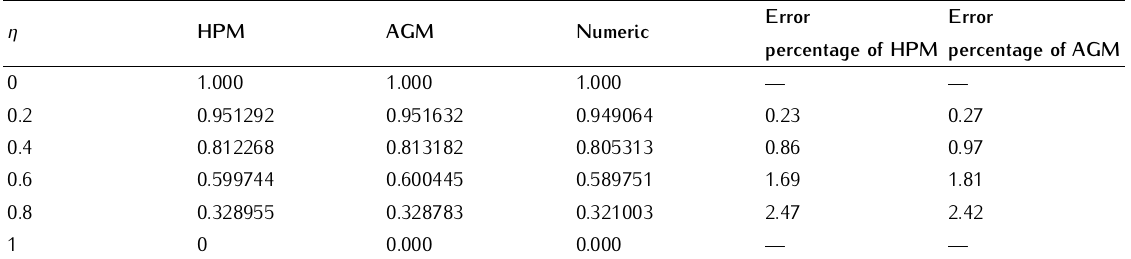
Table 2. Comparing the obtained values for f ( η ) by HPM and AGM with the numerical solution.